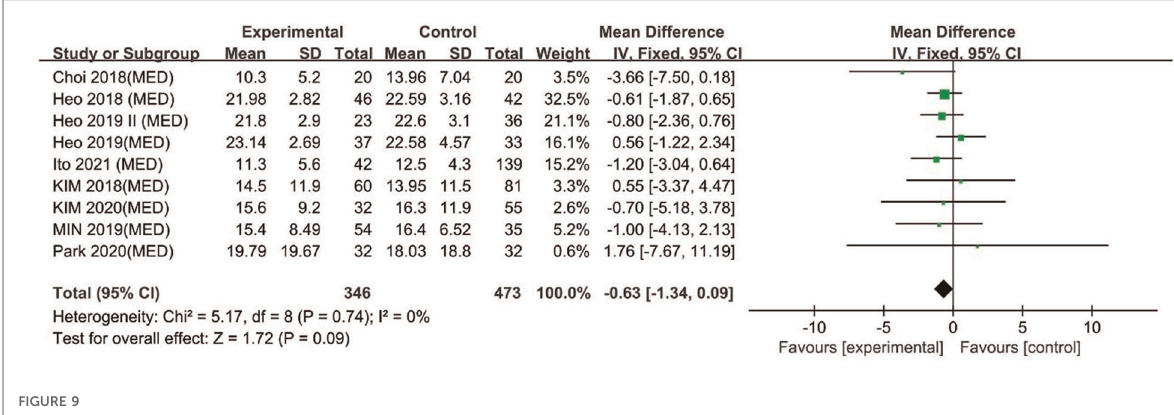
FIGURE 9 Forrest plot of ODI UBE vs